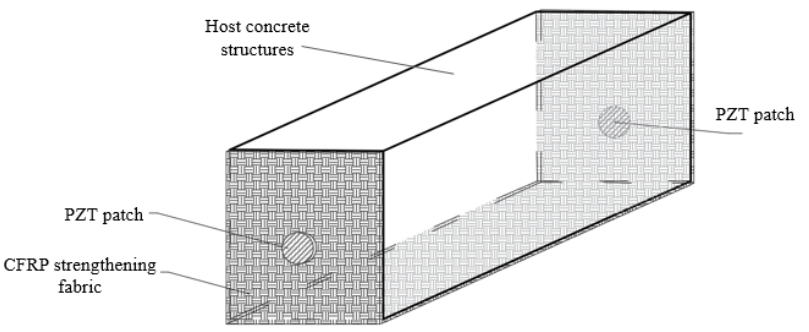
Figure 1. The schematic diagram of SCFRP fabric for strengthening the structures.